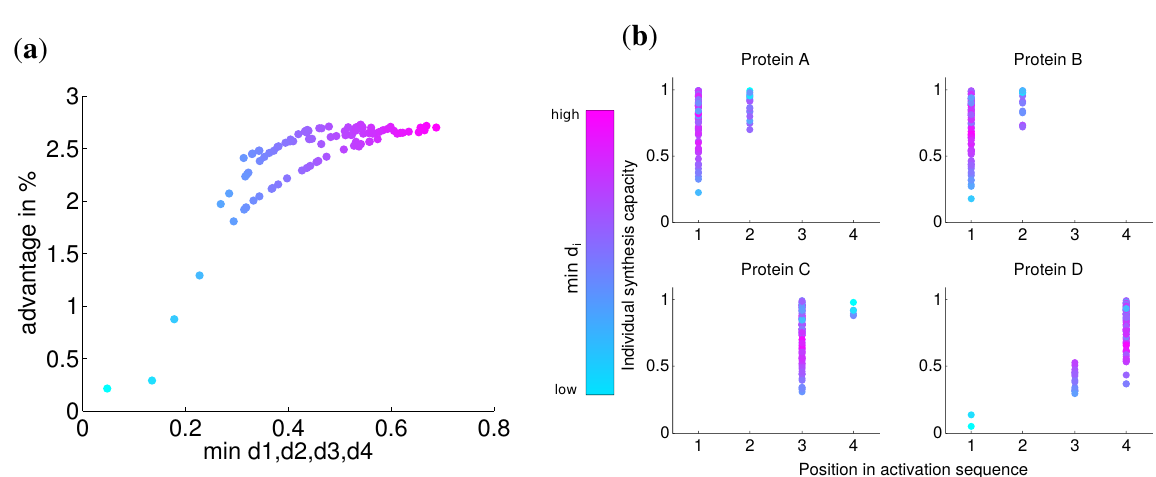
Figure 4. ( a ) Advantage of the optimal solution compared to a simultaneous synthesis of subunits; ( b ) Position in activation sequence compared to the individual synthesis capacity for the same parameter sets as in ( a ). In both figures colors represent the minimal individual synthesis